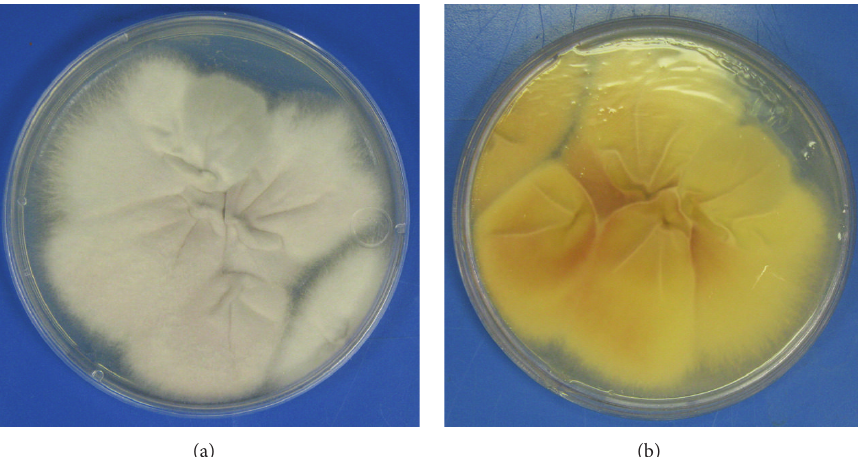
Figure 1: Sabouraud’s dextrose agar without cycloheximide showing cottony white mold (a) with cream-colored reverse (b).